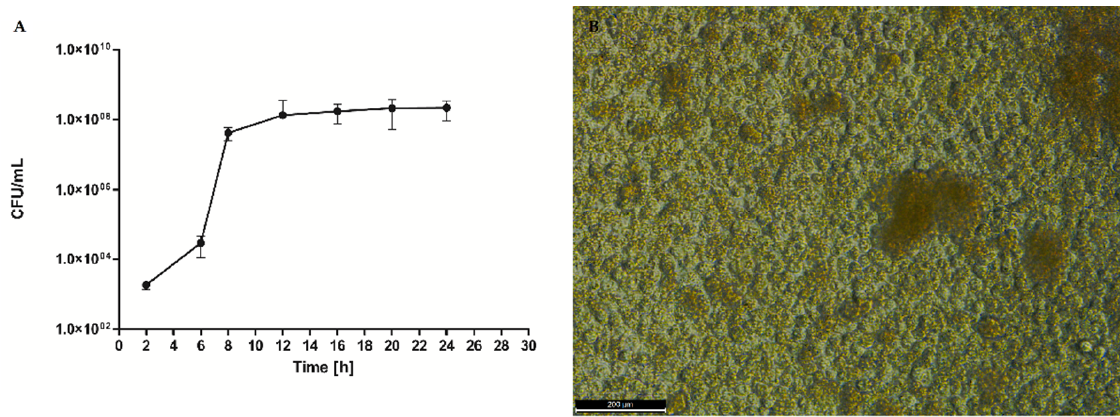
Figure 1. ( A ). S. aureus ATCC 6538 biofilm growth curve during 24 h of culturing. ( B ). Picture of S. aureus mature biofilm after 24 h post-inoculation taken with inverted microscope Leica DMIL LED, scale bar—200 µm, magnification 10×, Cfu—colony forming units .